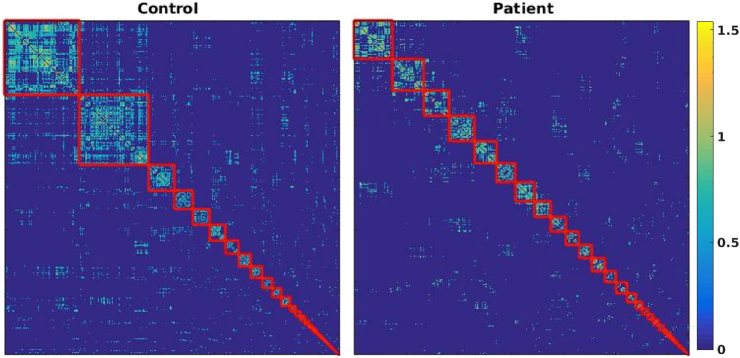
Region-by-region correlation matrices sorted by module membership obtained by Asymptotical Surprise for the two populations. Modules are demarcated by a red line. The number of modules is 44 and 39 for the control and patient group, respectively.